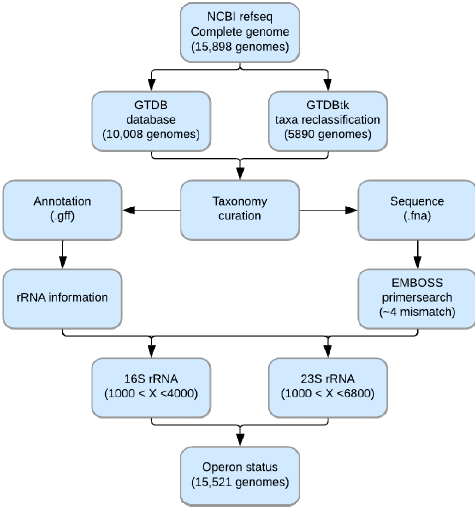
Figure 1. Flowchart of operon status identification from the complete genome sequence.